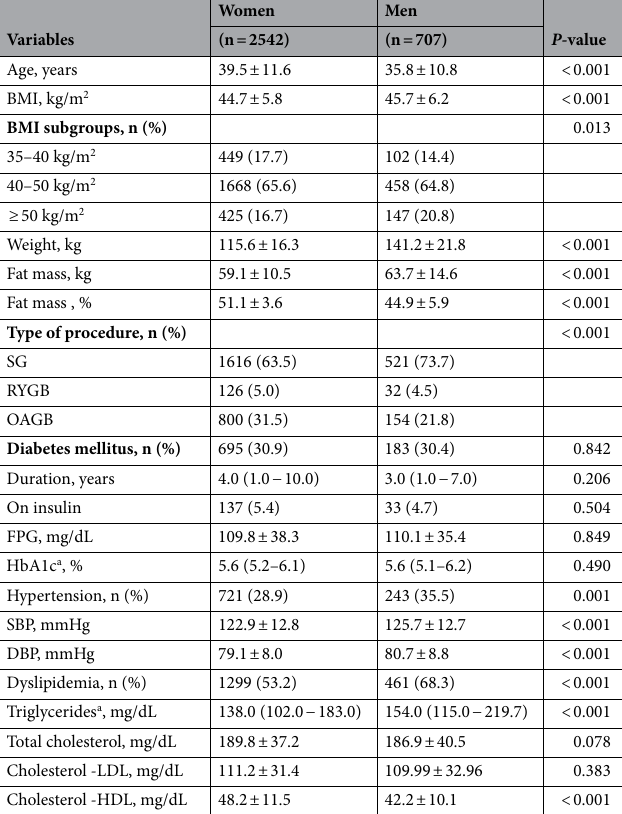
Table 1. Baseline characteristics of males and females, Tehran Obesity Treatment Study cohort, 2013 to 2019. BMI, body mass index; SG, sleeve gastrectomy; RYGB, roux-en-y gastric bypass; OAGB, one-anastomosis gastric bypass; FPG, fasting plasma glucose; HbA1c, glycated hemoglobin. SBP, systolic blood pressure; DBP, diastolic blood pressure; Continuous and categorical variables are represented as mean ± SD and frequency (percentage), respectively. a HbA1c and triglycerides are reported as median (IQR